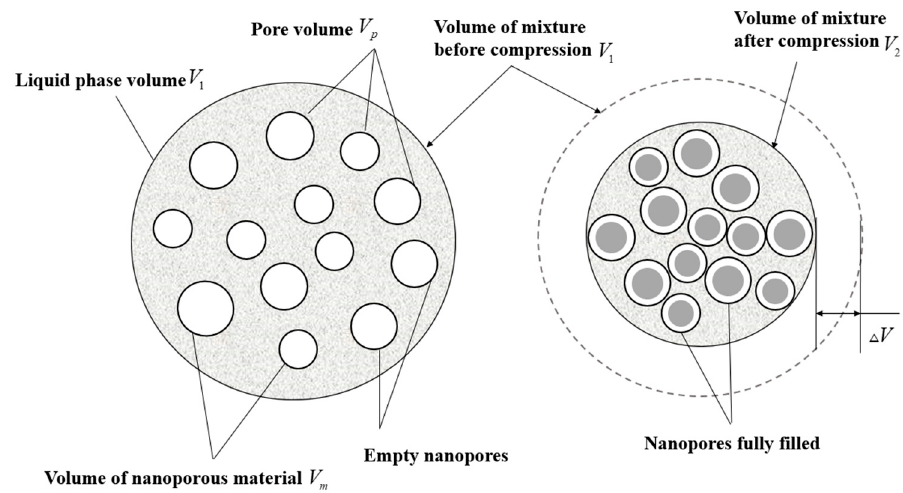
Figure 1. Schematic diagram of a nanofluidic system.